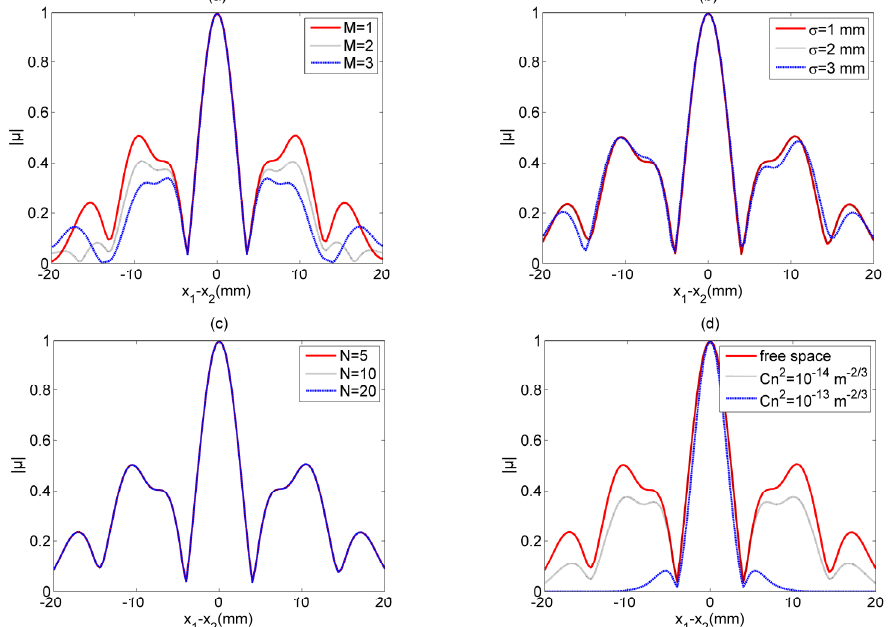
= Q = Q in the free space in the free space